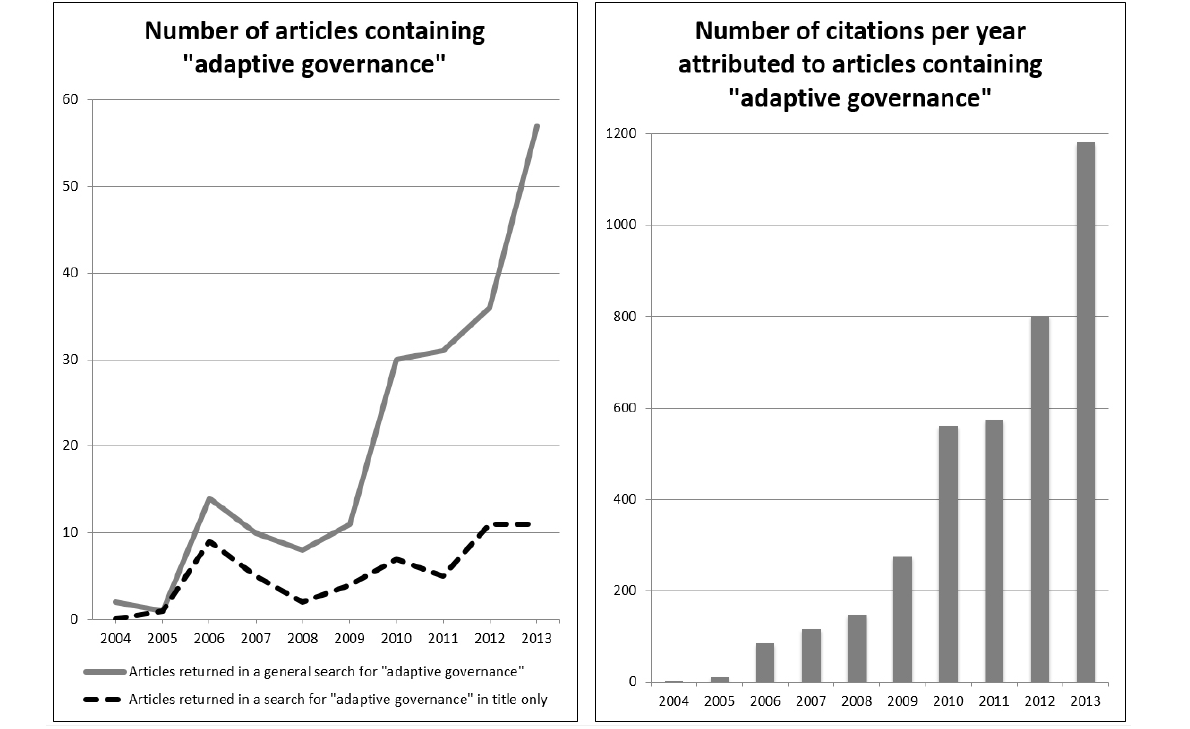
Fig. 1 . Adaptive governance citation record since appearance of term (2004-2014). Based on a Web of Science search 24 February